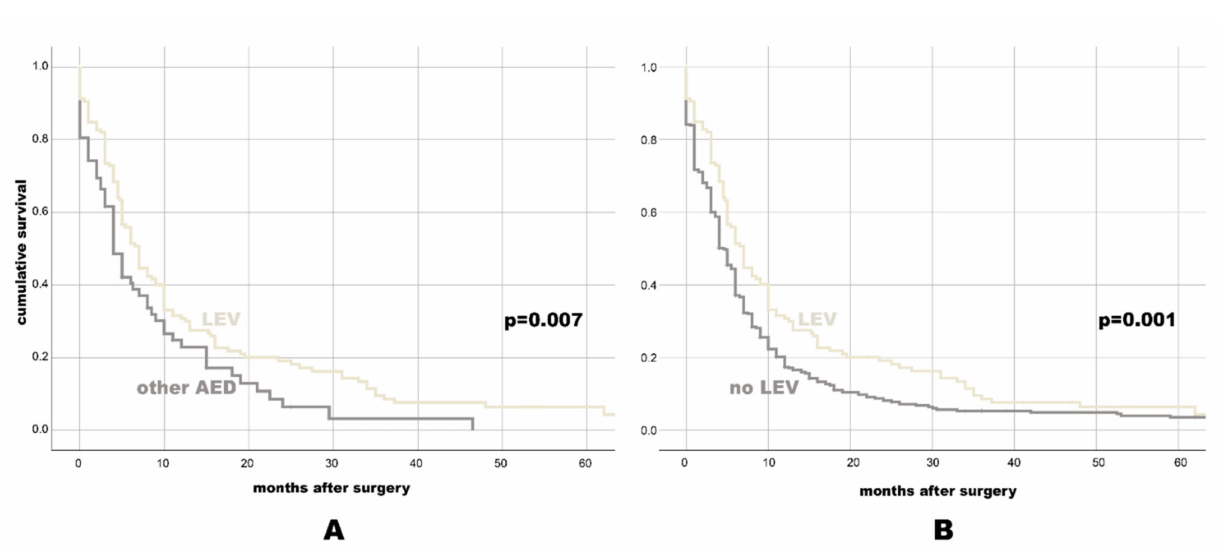
Figure 2. Kaplan-Meier-survival plot for PFS for individuals with LEV vs. any other AED ( A ), and for individuals with LEV vs. No LEV ( B